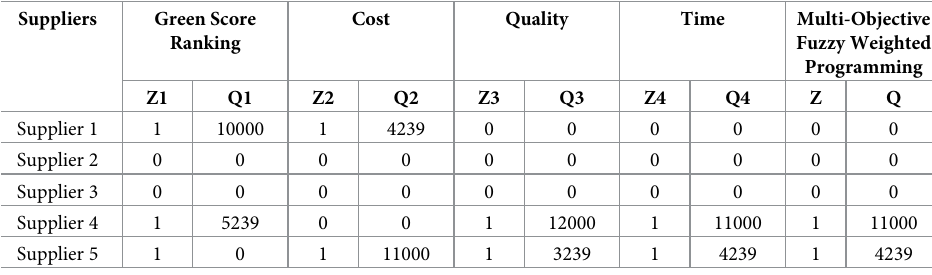
Table 16. Demand and capacity constraints